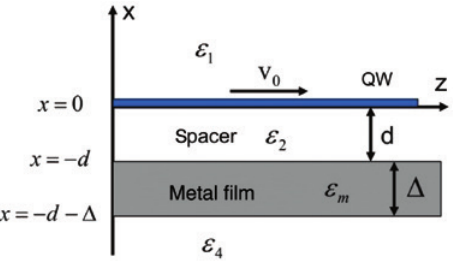
Figure 1: Simplified scheme of the nanoresotron. Plasma oscillations in a quantum well (QW) carrying DC current result in surface wave amplification at the metal film. ε to 4 are the permittivities of the media, ε of the electrons in the